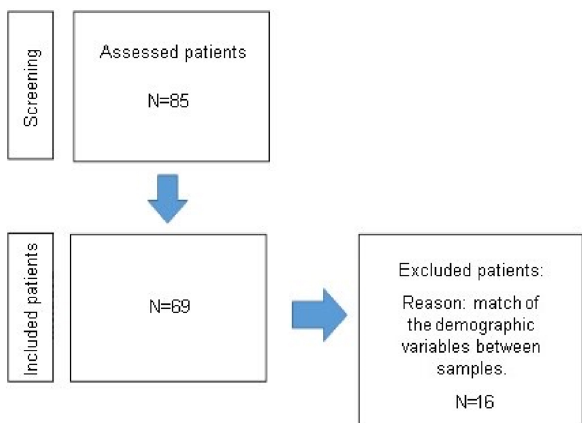
Figure 1. Flowchart of criteria for sample